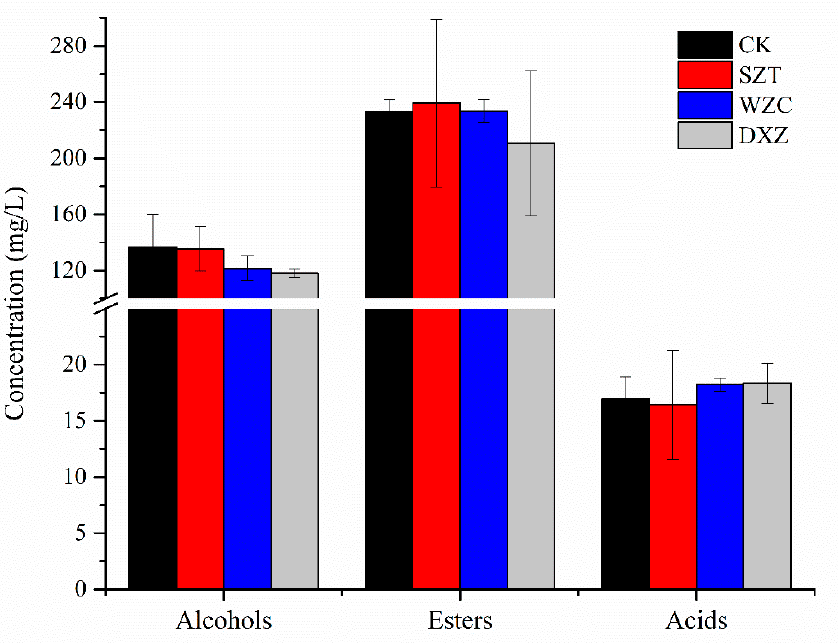
Figure 5. Comparison of relative volatile components of the four wine samples. Blank (CK), triadimefon-treated (SZT), tebuconazole-treated (WZC), and paclobutrazol-treated (DXZ) wine samples. Diverse Volatile